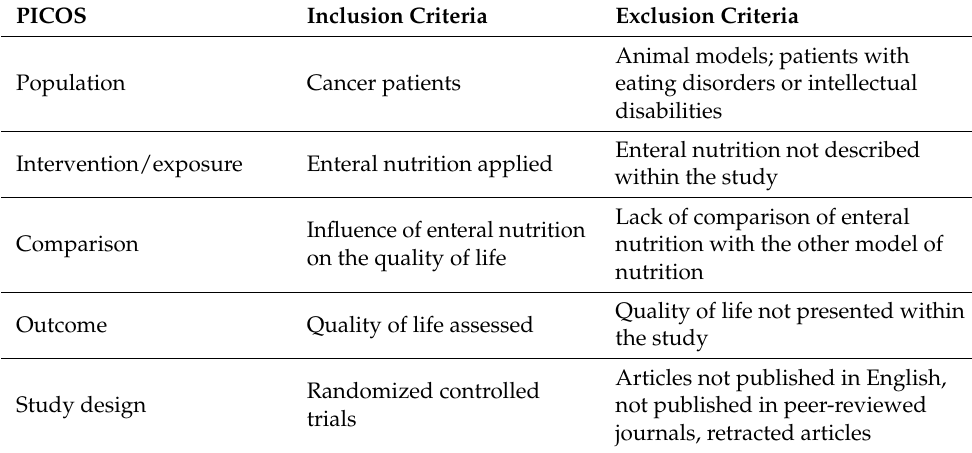
Table 1. The summarized inclusion and exclusion criteria for a patient, intervention/exposure, comparator, outcome, and study design